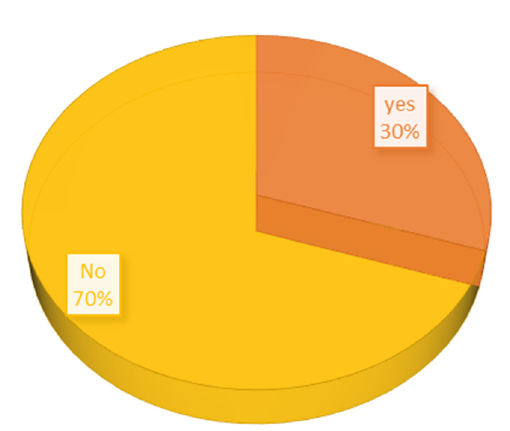
Figure 4. Using wood waste (sawdust) for other products.